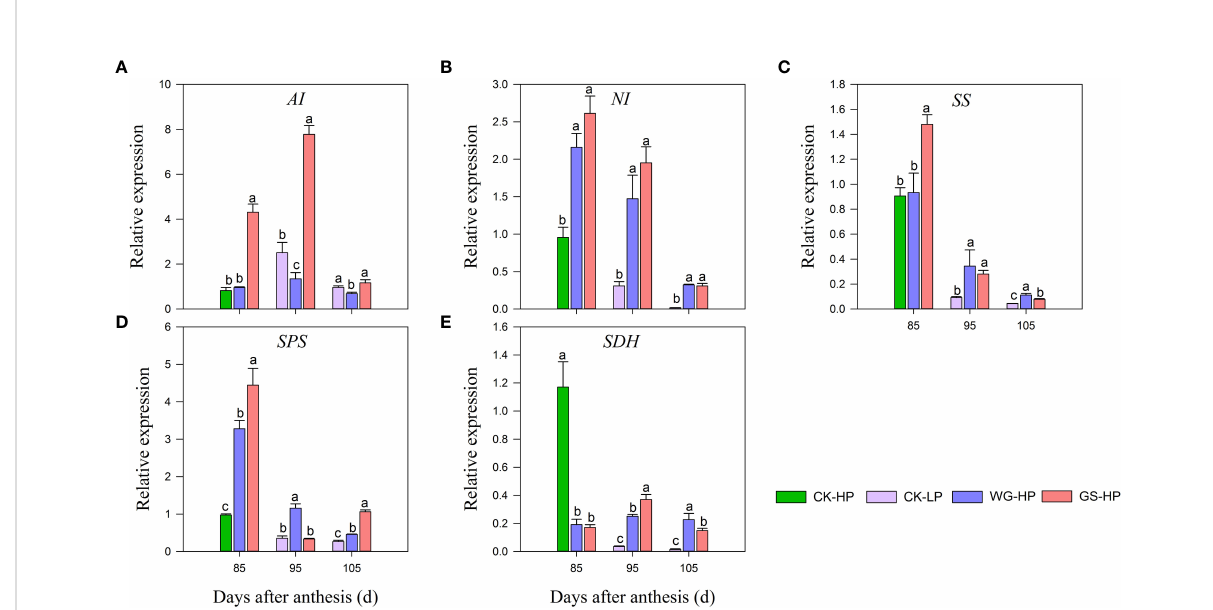
FIGURE 3 Transcript levels of sugar-related genes in different treatments. CK-LP means green skin of ‘ Yinhongli ’ plum, the rest are red skin. Values are mean ± SD (n =3). Different letters indicate signi fi cantly different values at p < 0.05. AI, acid invertase (A) ; NI, neutral invertase (B) ; SS, sucrose synthase (C) ; SPS, sucrose phosphate synthase (D) ; SDH, Succinate dehydrogenase (E)